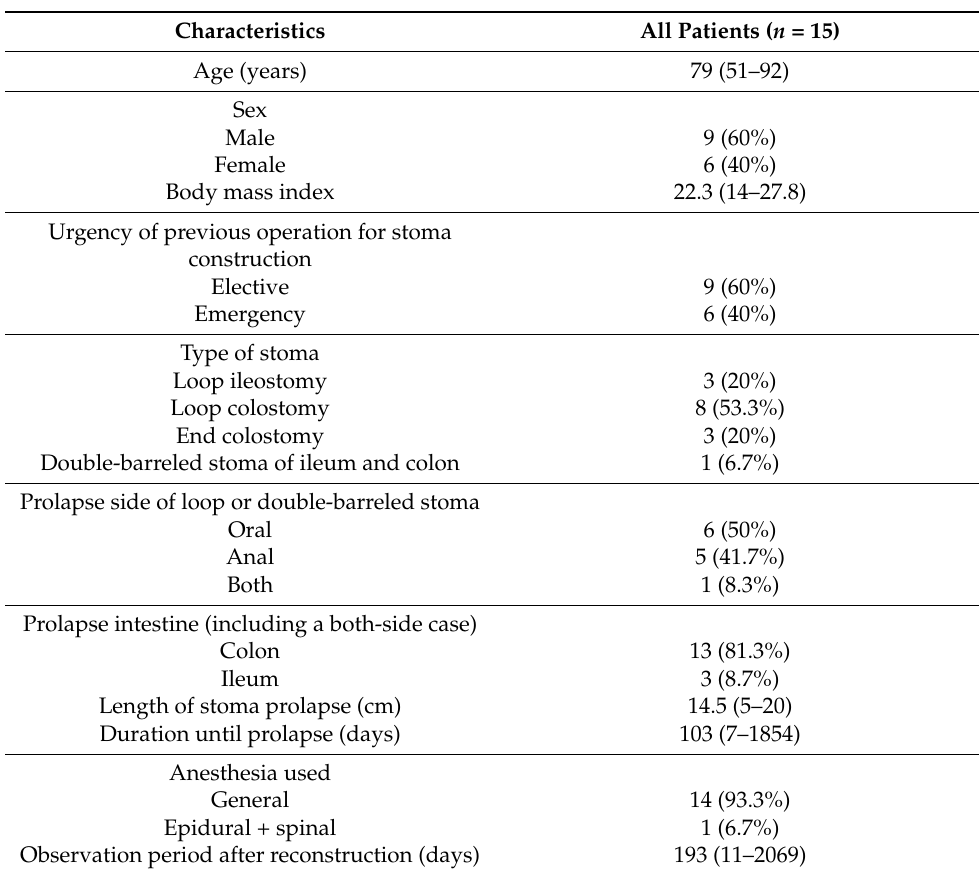
Table 1. Baseline patient